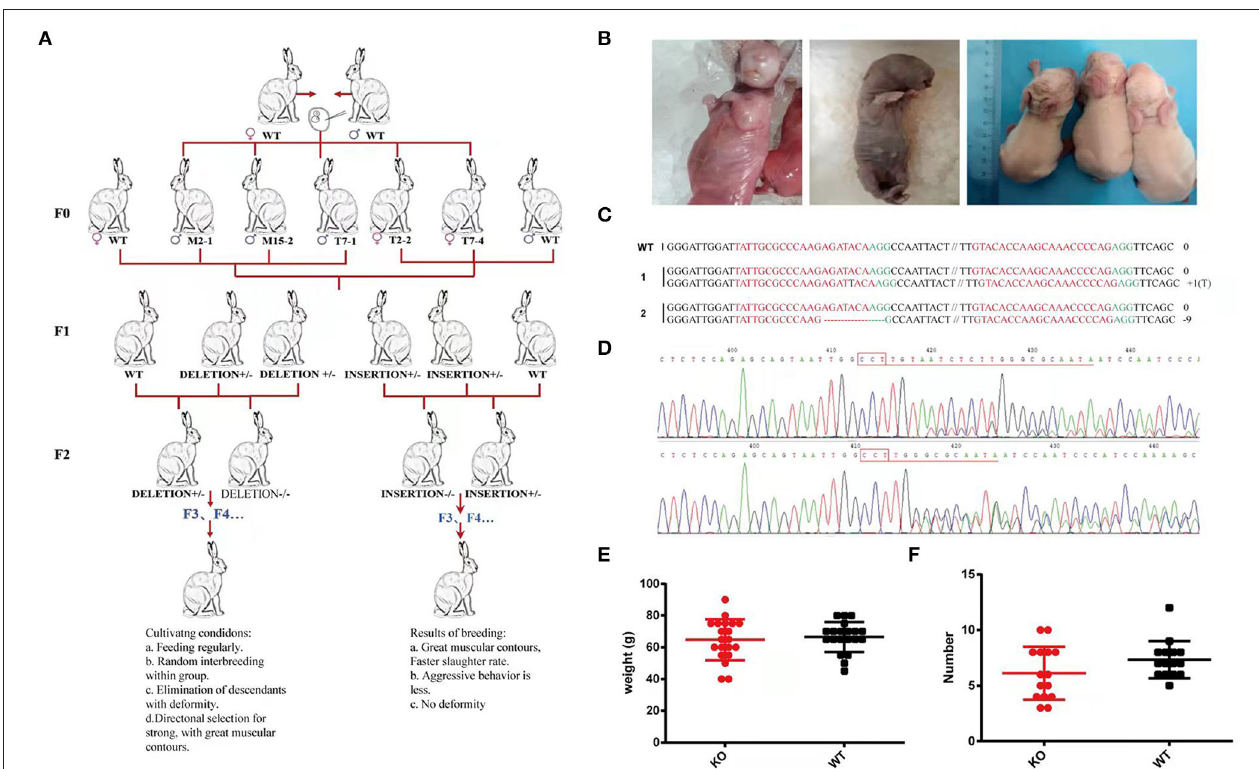
FIGURE 8 | (A) Schematic diagram of MSTN -KO rabbits breeding family. (B) Left: A cub with a large tongue. Right: Difficult to give birth due to the large size of the cubs. (C) Rabbits of F1 were named on the left. 1-2 represent different rabbits, PAM sequence is marked in green. The sgRNAs sequence is marked in red. The numbers on the right indicated the type of mutation, with “-” represents deletion of the given number of nucleotides, “ + ” represents insertion of the given number of nucleotides. (D) sequence identification. (E) Birth weight of rabbits. (F) Litter